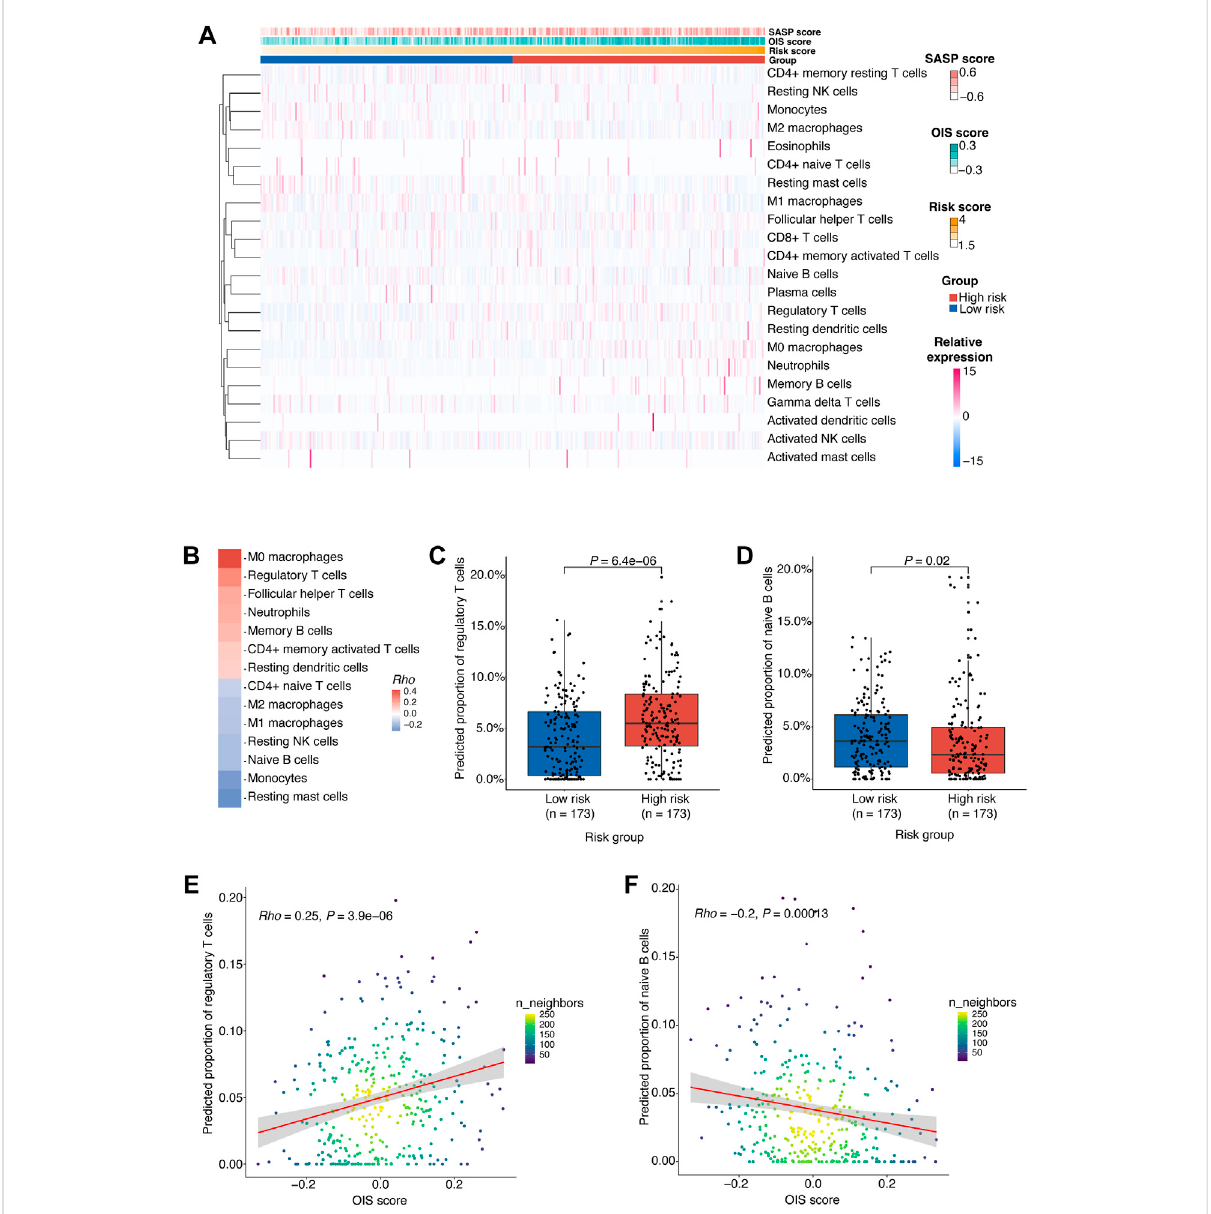
FIGURE 6 PotentialregulatoryeffectsofOISontheimmunemicroenvironmentinHCC. (A) 22typesofimmunecells ’ proportionpredictedbyCIBERSORT in HCC tumors from TCGA ranked according to the risk score. (B) A heatmap of correlations between immune cells proportion and the risk score. The p values were determined by Spearman rank correlation analyses and immune cells with p < 0.05 were kept. (C) The proportions of Tregs in the high-andlow-riskgroups. (D) TheproportionsofnaïveBcellsinthehigh-andlow-riskgroups. (E) Ascatterplotofthecorrelationbetweenthe OIS score and the proportion of Tregs. (F) A scatter plot of the correlation between the OIS score and the proportion of naïve B cells. In (C,D) , the p values were assessed by Wilcox test. In (E,F) , the correlation coef fi cients ( rho ) and p values were determined by Spearman rank correlation analyses and the color represents the density of the scatters. HCC, hepatocellular carcinoma; TCGA, the cancer genome atlas; OIS, oncogene-induced